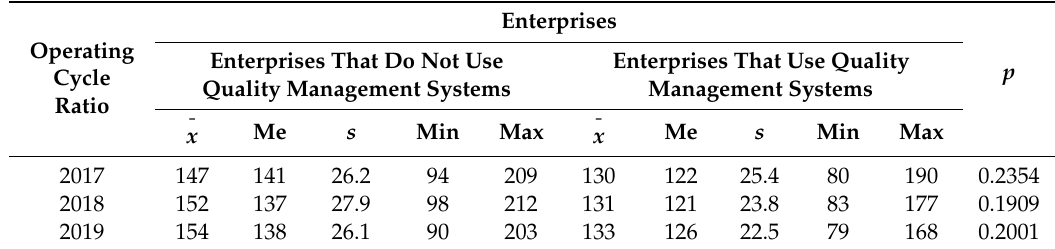
Table 3. Average results for the operating cycle ratio (in days).